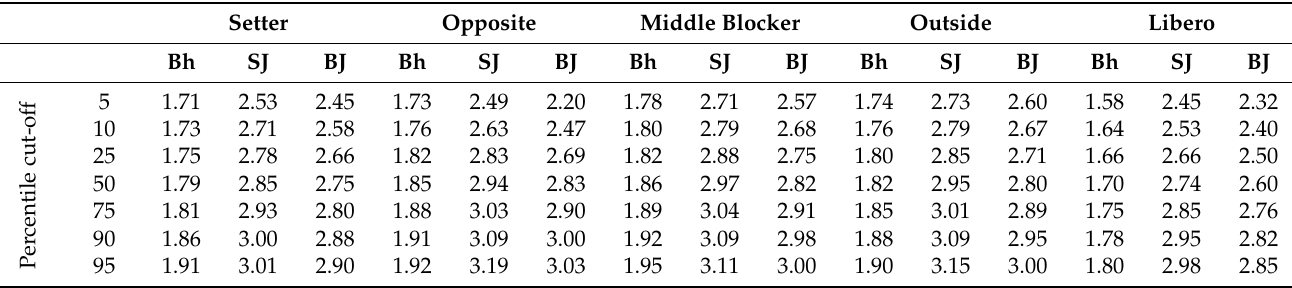
Table 3. Position-specific normative centile values of body height, spike jump, and block jump for junior female volleyball players. Setter Opposite Middle Blocker Outside